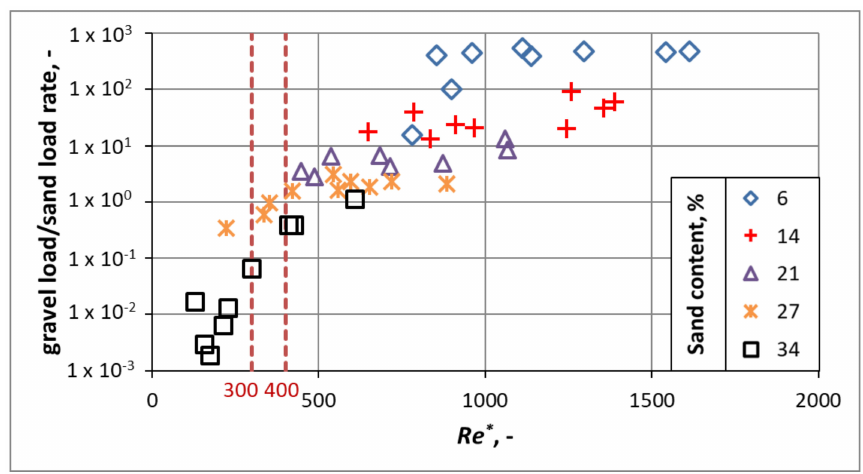
Figure 4. Calculated rates of the gravel load to the sand load as the function of the shear Reynolds number, based on the laboratory experiments of Wilcock et al.